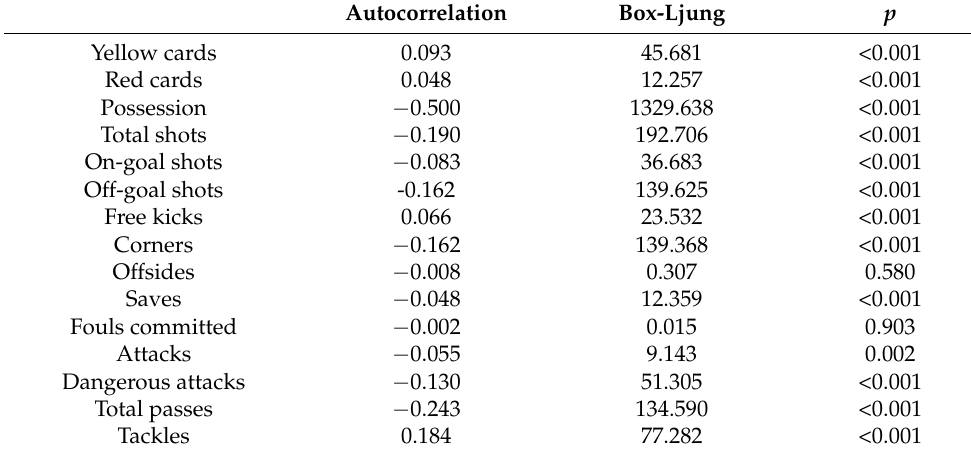
Table 6. Autocorrelation of the